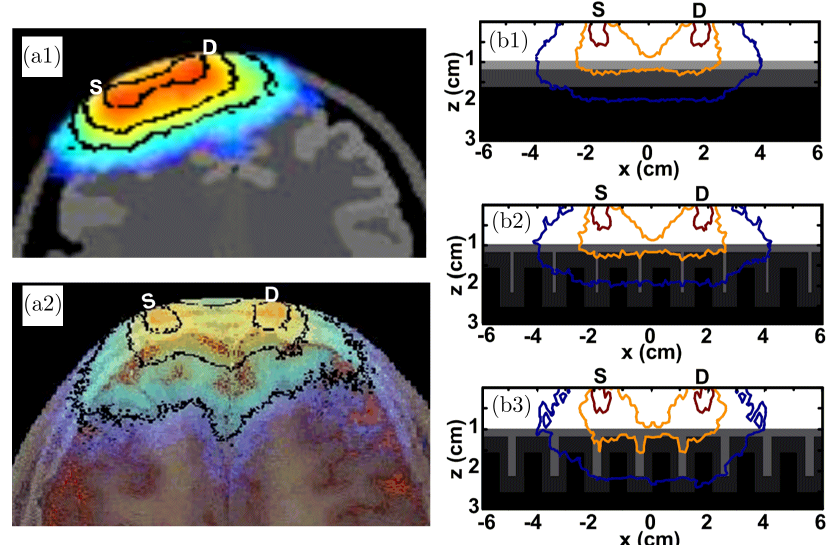
Fig. 2. Spatial sensitivity pro¯les in the Zubal MRI head model (a1) and VCH head model (a2), layered head model (b1) and arti¯cial head models (b2), (b3) derived from the paper of Okada. 10 The separation between light source and detector in each model equaled 3.7 cm. The width of slots in (b3) is triple of that in